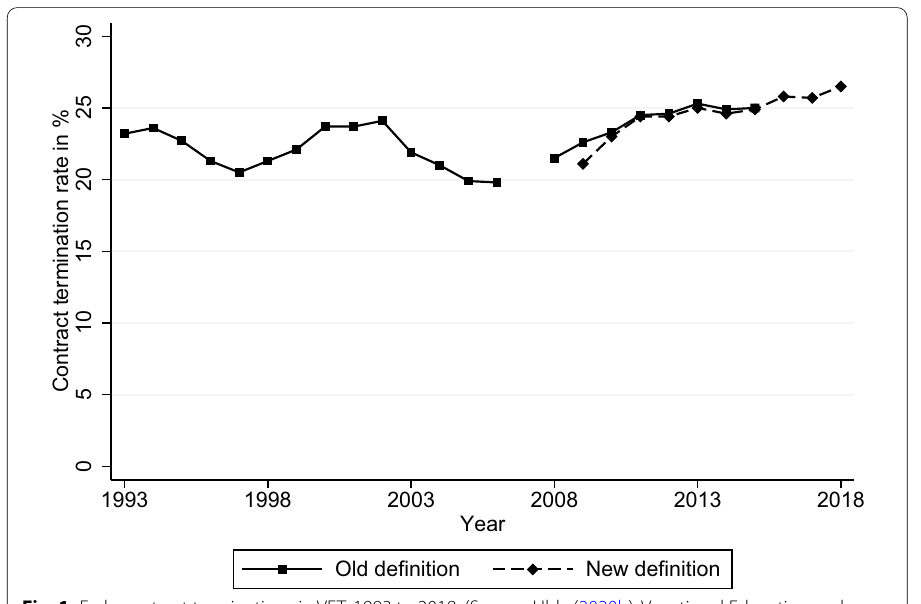
Fig. 1 Early contract terminations in VET, 1993 to 2018. (Source: Uhly (2020b), Vocational Education and Training Statistics of the Federal Statistical Office and the Statistical Offices of the Länder with survey date December 31, 1993 to 2018. Note: The new definition is a summation of the contract termination rates by apprenticeship year. The old definition could use this approach only by approximation. Note further, in 2007 the survey method was substantially changed, thereby enabling calculations according to the new definition. Consequently, however, rates before and after 2007 can only be compared with considerable